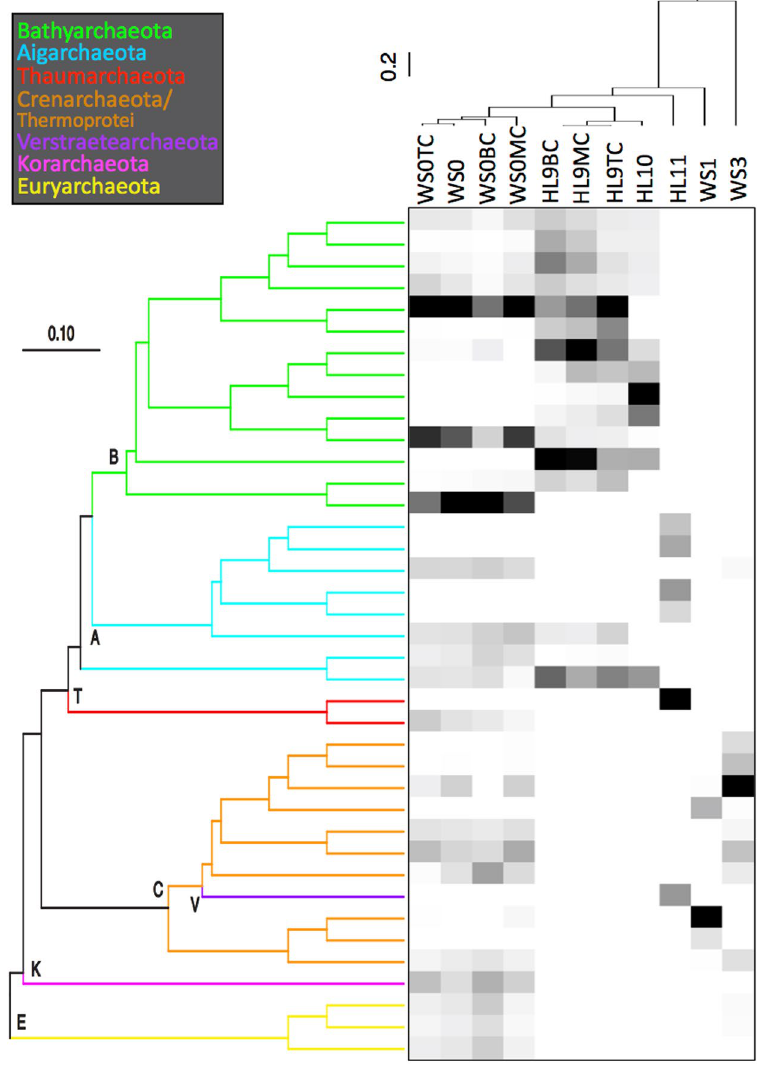
Figure 2. Phylogenetically resolved heat map of OTU occurrence and beta diversity across sampling sites. The relative abundance of OTUs representing > 0.5% of the archaeal community is shown as a gradient from black (high abundance) to white (low abundance). A comparison of phylogenetic diversity for each sampling site is represented as a weighted UniFrac UPGMA dendogram of jackknifed phylogenetic resampling of the rarified OTU table, and demonstrates the major clustering patterns among hot springs from varying hydrothermal regions. OTU relationships are presented as a neighbor-joining tree with justified branch lengths in which branches from the same phylum are the same color corresponding to the legend. For clarity, the first letter of each phylum is placed at its respective node (B = Bathyarchaeota ; A = Aigarchaeota ; T = Thaumarchaeota ; C = Crenarchaeota ; V = Verstraetearchaeota ; K/E = Korarchaeota / Euryarchaeota ). Following the sample IDs, the designations “TC”, “MC”, and “BC” stand for “top core”, “middle core”, and “bottom core”, respectively. NB: The paraphyletic groupings of Crenarchaeota and Verstraetearchaeota are resolved in the full phylogenetic tree that includes long fragment reference sequences (Supplementary Figure